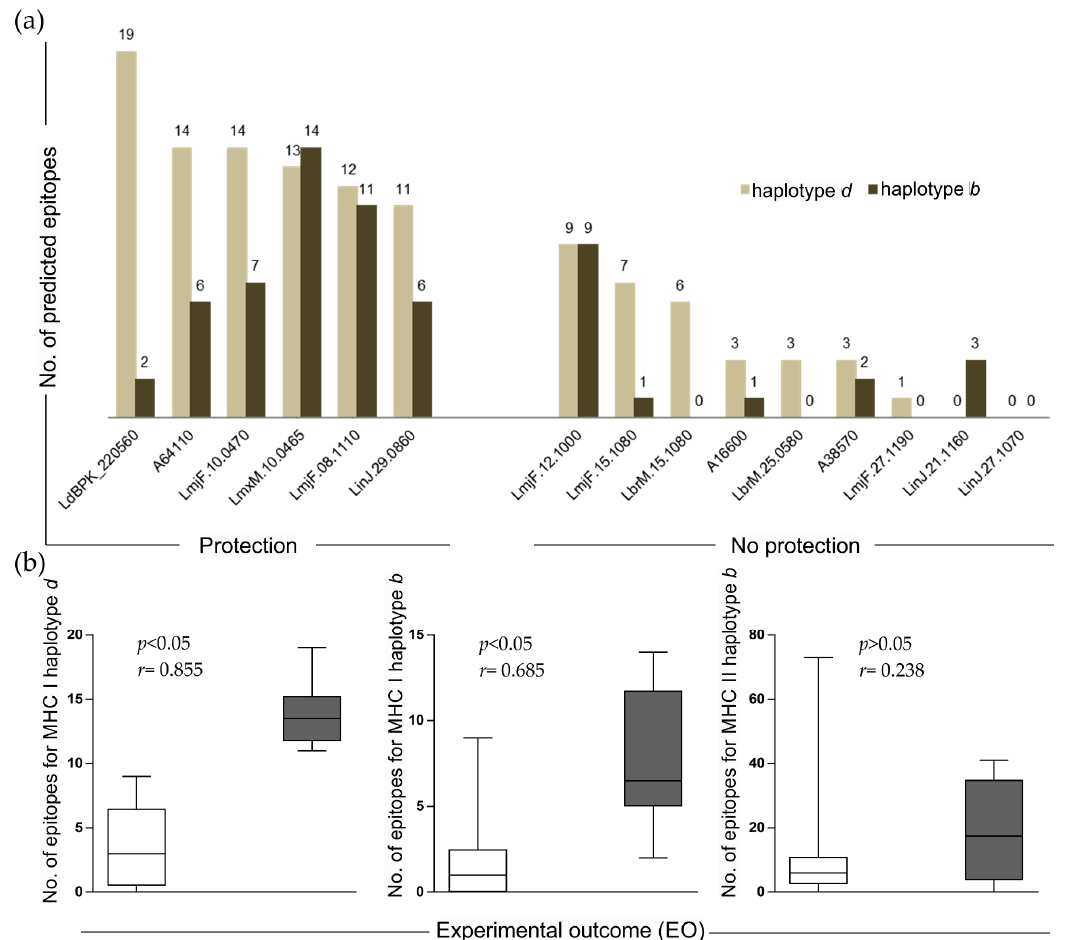
Figure 2. Evaluation of epitopes amount and relationship with experimental outcome: ( a ) bar graph showing number of epitopes for MHC class I and II (haplotype d and b ) in the selected antigens classified in “protection” and “no protection” groups; and ( b ) box plot of the relationships between CD4 + and CD8 + T cell epitopes and experimental outcome of candidate antigens.